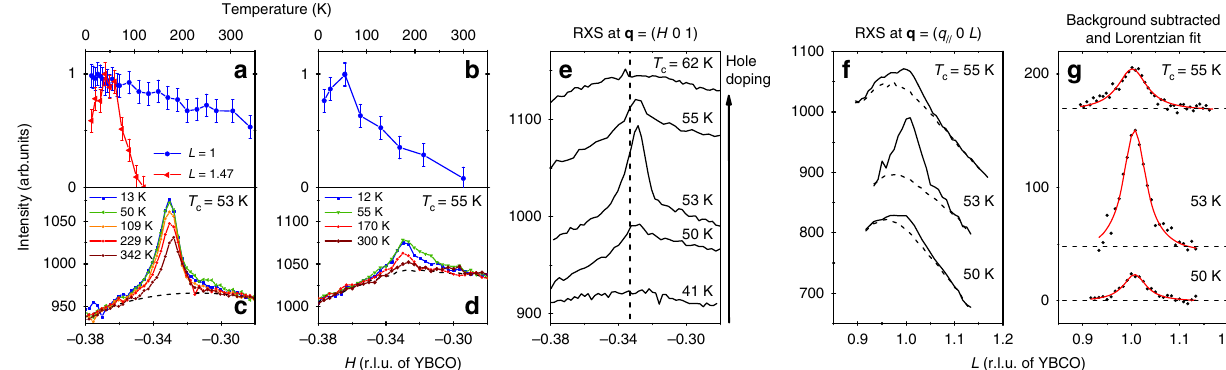
Fig. 2 Temperature and doping dependence. a – d Temperature dependence of the scattering intensity along the ( H 0 1) reciprocal space direction for two 50 nm fi lms with T c = 53 K ( a , c ) and 55 K ( b , d ). The backgrounds (dashed lines) in c , d were achieved by slightly detuning the detector angle away from the Bragg condition, and then subtracted before integrating to produce the normalized data points in a , b (blue circles). For comparison the temperature dependent intensity of the 2D-CO rod collected at L = 1.47 is shown in a (red triangles). e Scattering intensity at 12 K along ( H 0 1) for fi ve YBCO fi lms of equal thickness (50 nm), but varying doping, as indicated by variation in the superconducting T c (see “ Methods ” ). The commensurate momentum transfer H ¼ (cid:2) 1 is indicated by the dashed vertical line. f L -scan of the 3D-CO re fl ection for the 50 nm fi lms with T c = 50, 53, and 55 K. The background was 3 obtained in the same manner as described for c , d . g Same data as in f after background subtraction (black circles), and fi tting with Lorentzian pro fi les (solid red line). a – g All data were collected using σ polarized X-rays tuned to the Cu L 3 resonance. For clarity, vertical offsets were added to the curves in e – g . Although our data does contain statistical noise, the error in our analysis is dominated by the uncertainty in determining the intrinsic background signal. Accordingly, the error bars in a , b were estimated from a sensitivity analysis of the background subtraction